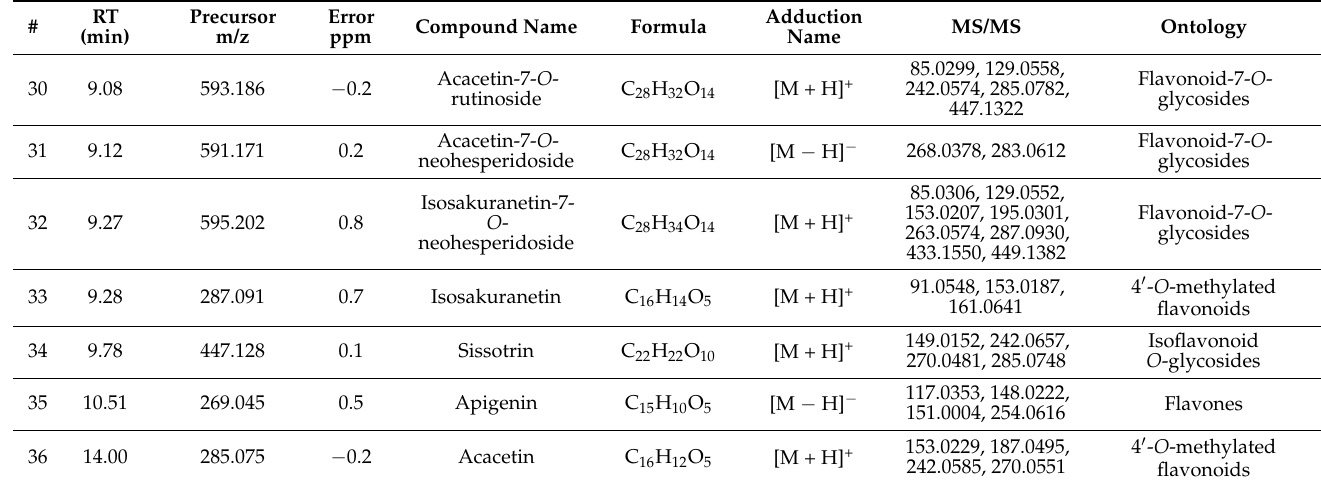
Figure 5. Antiviral activity of Salvadora persica methanol extract (IC 50 of 8.946 ± 0.02 µg/mL) against the HSV-2 virus. The results are presented as the mean ± SD.